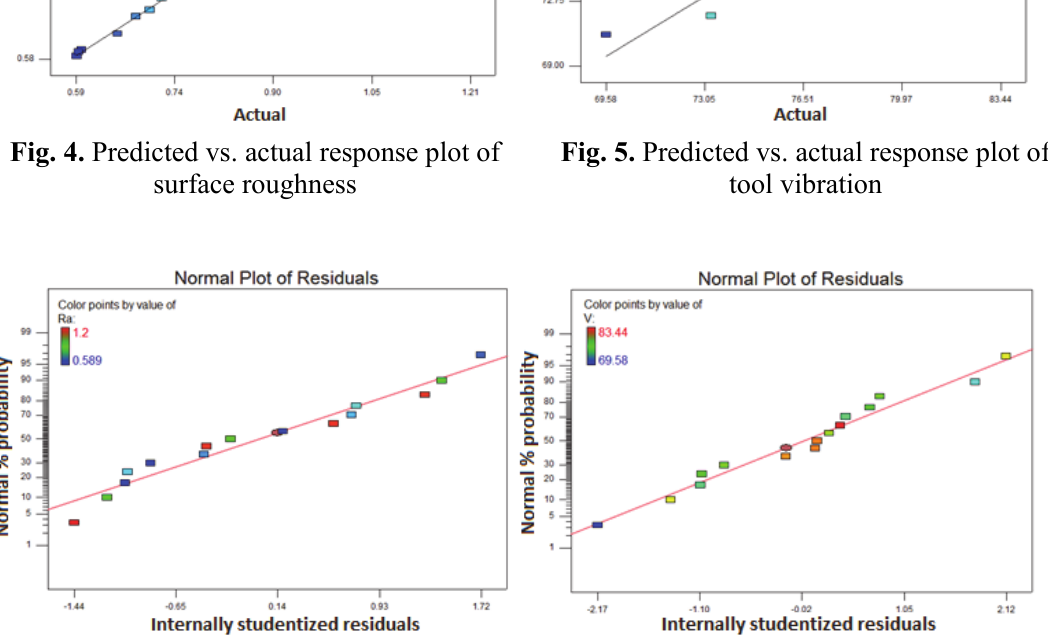
Fig. 6. Normal probability plot of residuals for surface roughness